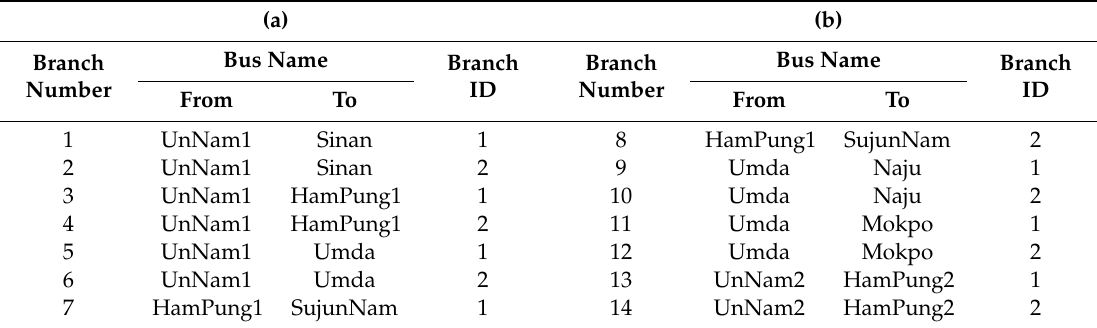
Table A1. Branch number information.